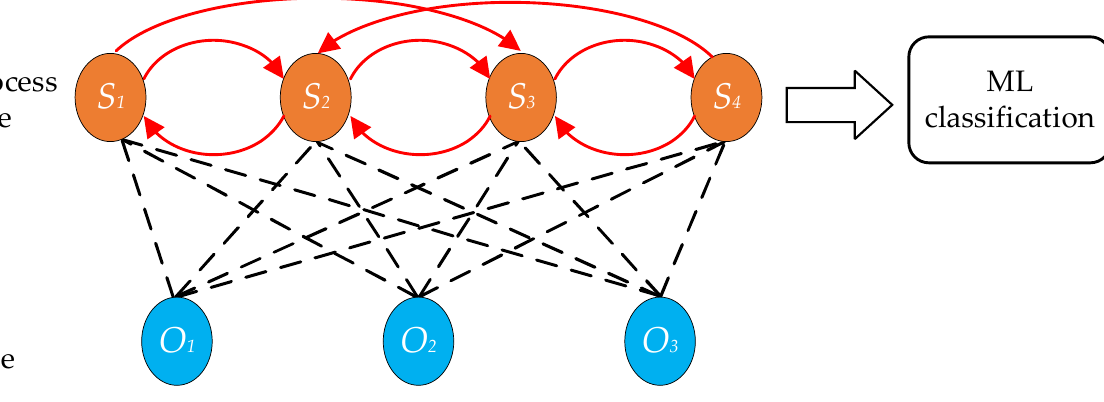
Figure 15. Hidden Markov model-based classification.